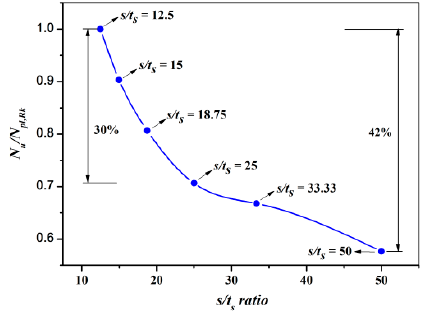
Figure 19. The relation between normalized strength and plate slenderness (s/ts).